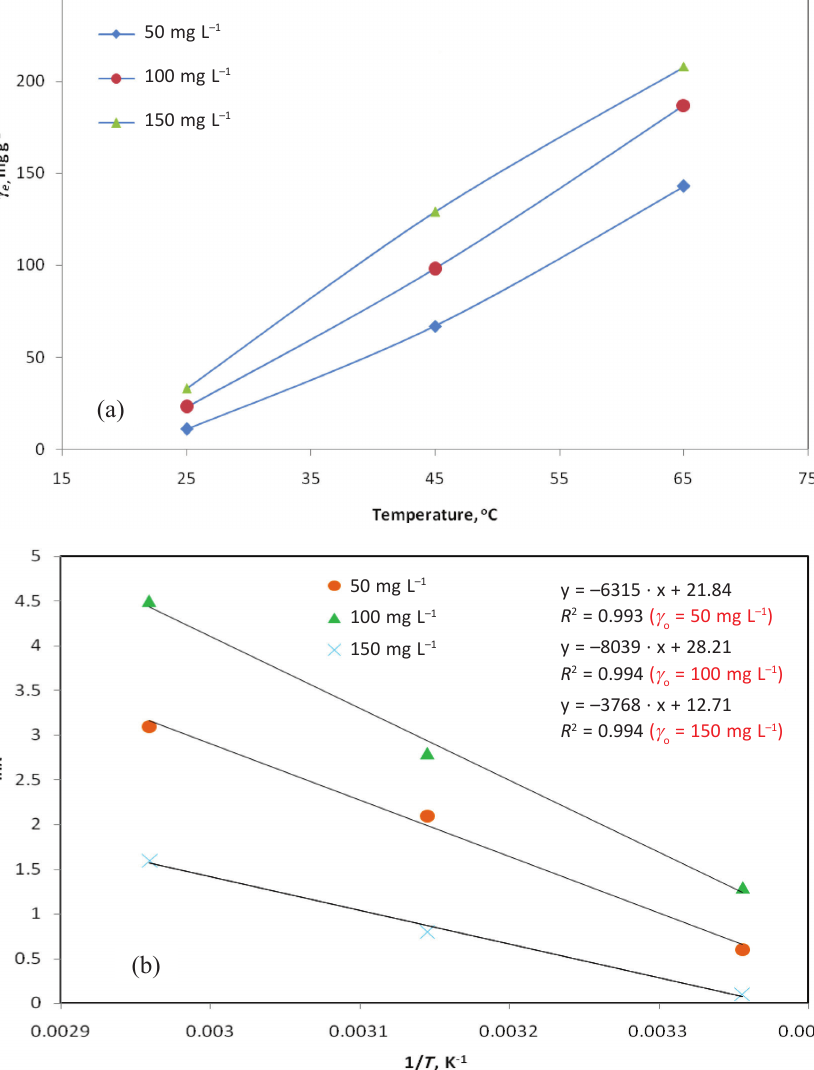
Fig. 12 – Effect of temperature on Cr(VI) adsorption (a) and plot of lnK versus 1/T